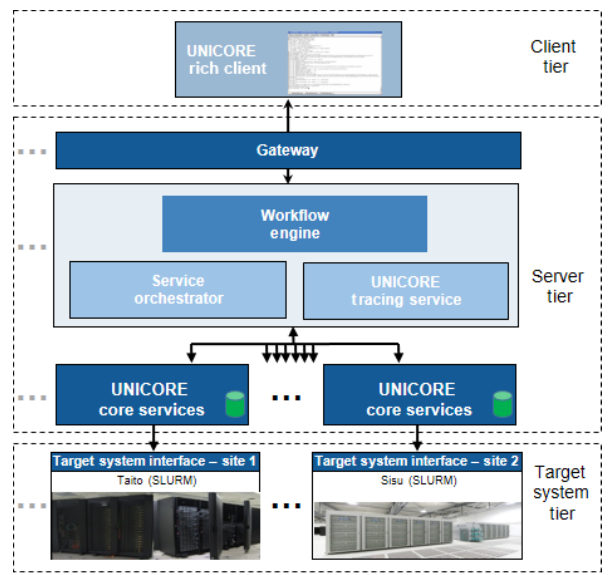
Figure 3. Multi-tiered UNICORE